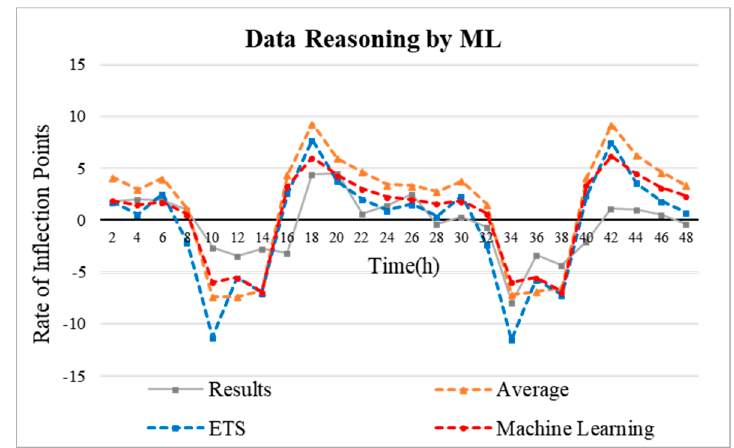
Figure 7. Data Analysis and Forecasting.